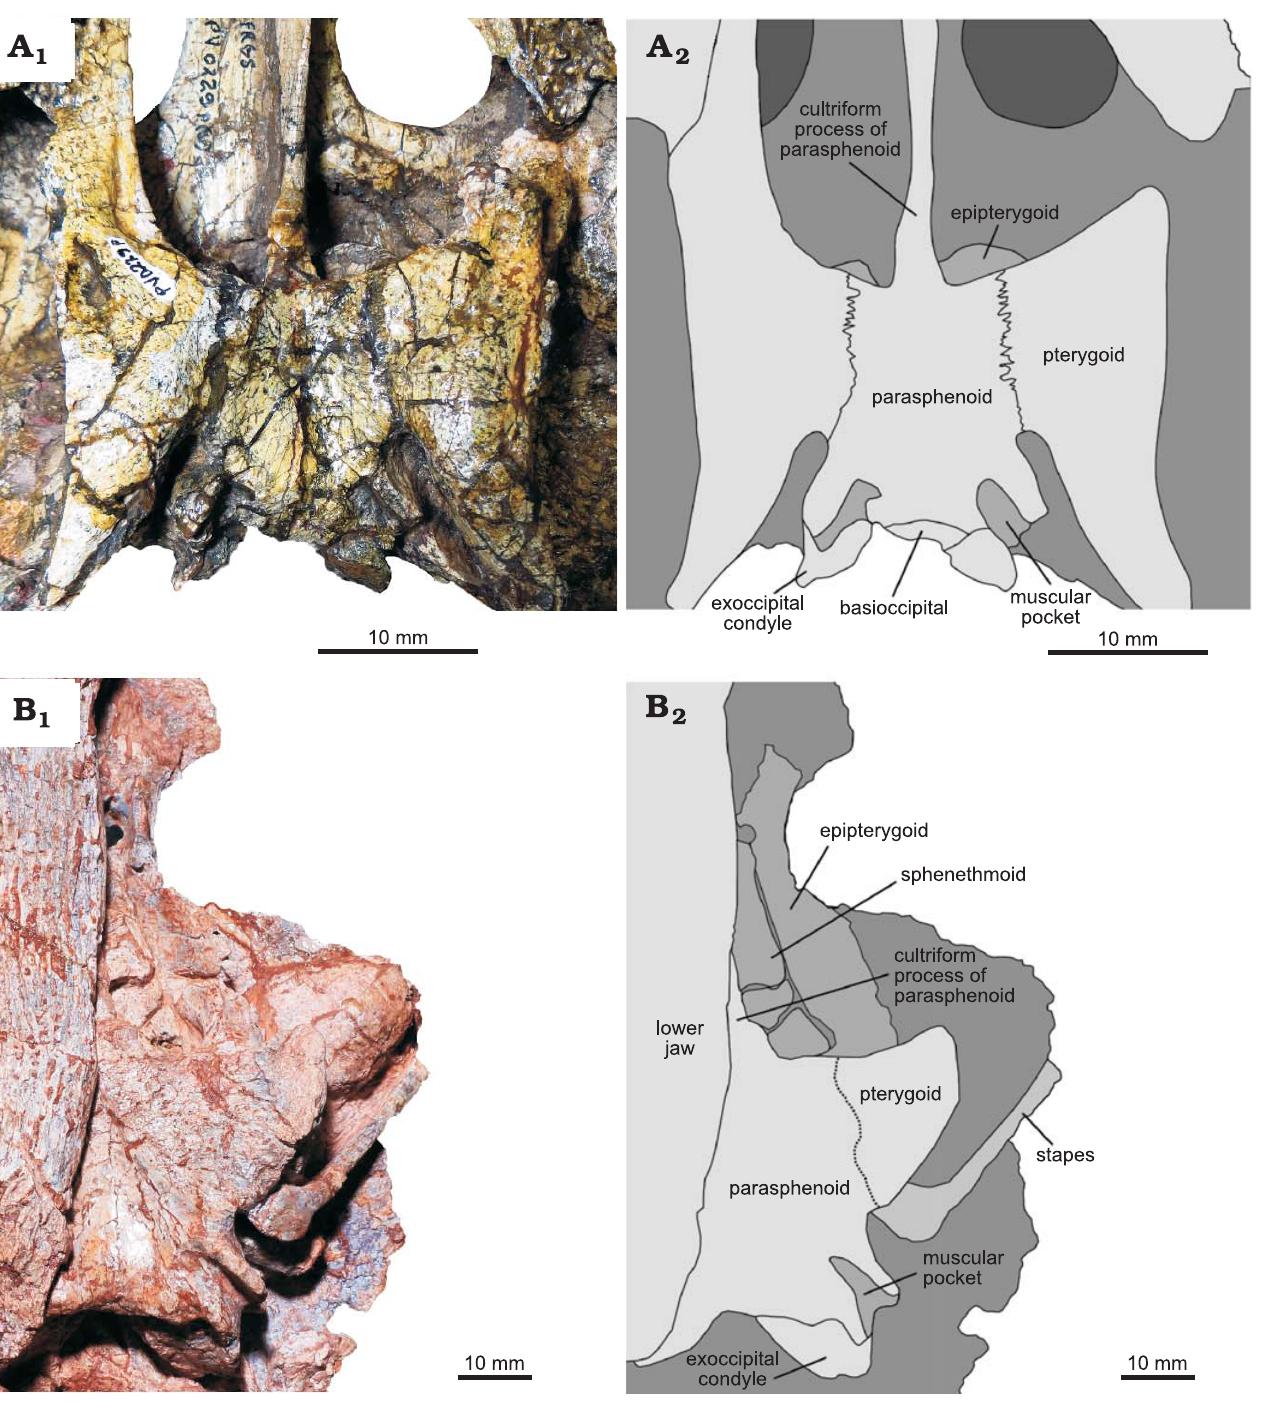
Fig. 8. Comparison between the posterior part of the skull of temnospondyl Australerpeton cosgriffi , (Barberena, 1998) (UFRGS PV 0229 P in ventral view) from the Paraná State (Brazil), Upper Permian ( A ) and the stereospondylomorph temnospondyl Parapytanga catarinensis gen. et sp. nov. (holotype, UFRGS- PV-0355-P in ventral view) from the Santa Catarina State (Brazil), Middle–Upper Permian ( B ). Photos (A 1 , B 1 ) and interpretative drawings (A 2 , B 2